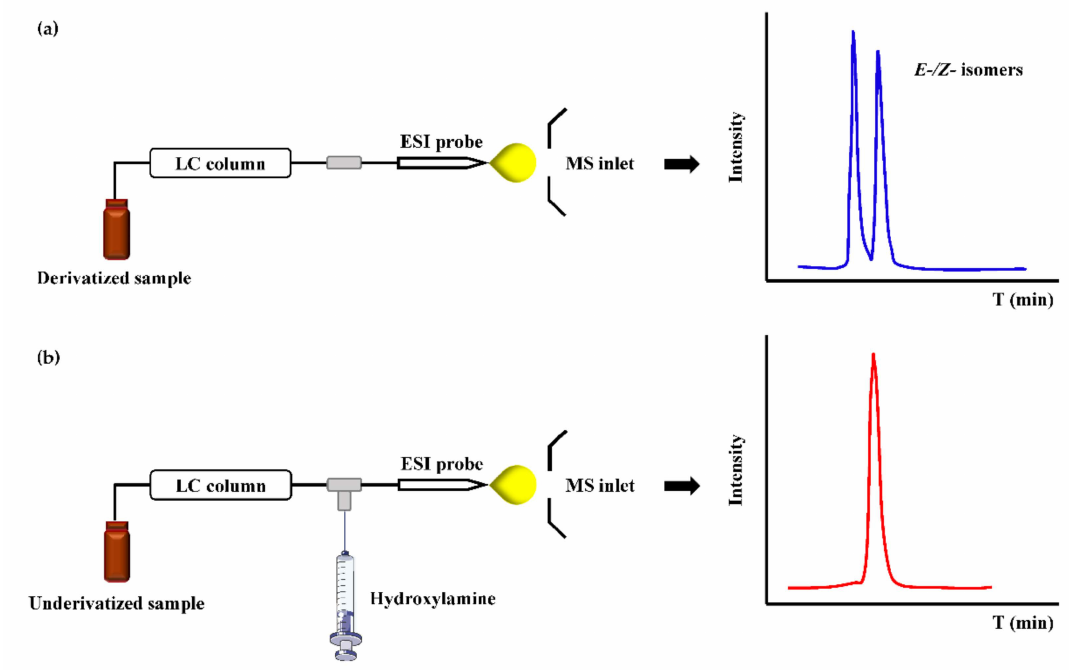
Figure 4. The scheme and chromatogram of oxime derivatives obtained by ( a ) pre-column derivatization and ( b ) post- column